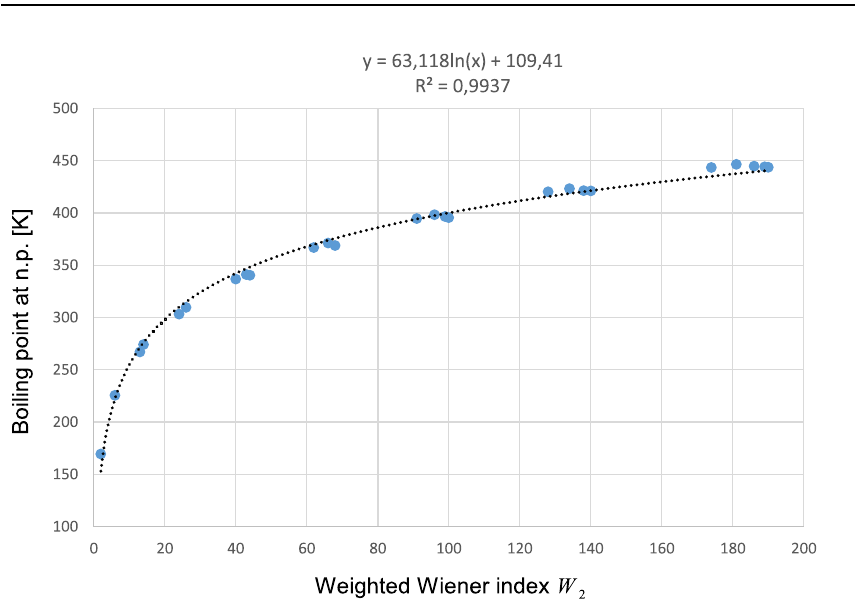
Figure 4. Weighted Wiener indices W 2 and boiling points for the unbranched